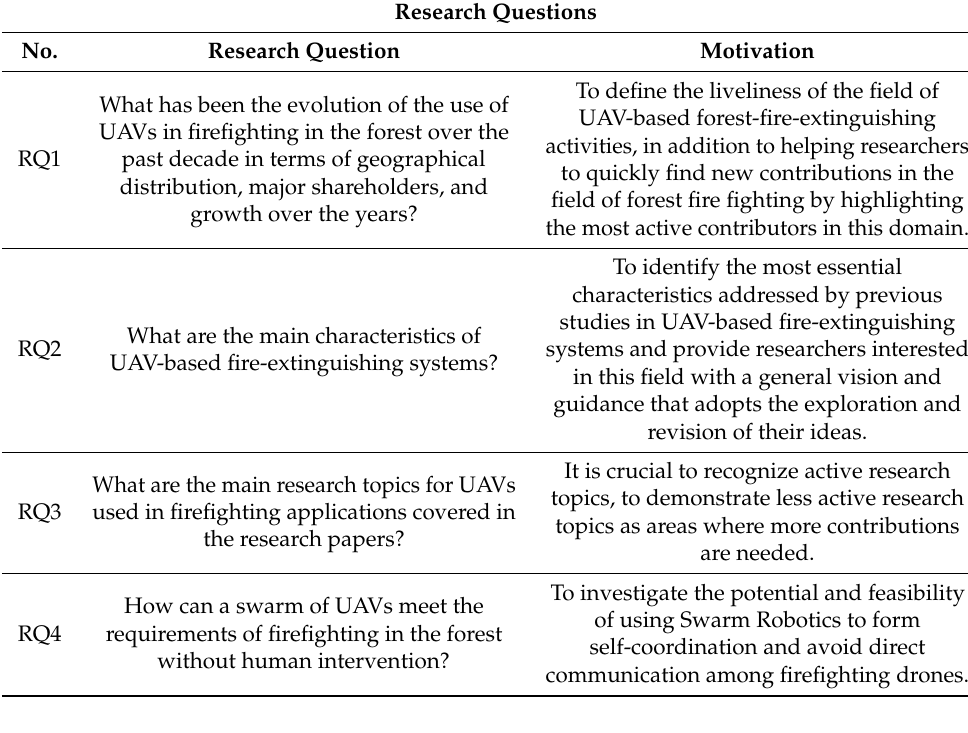
Table 2. SLR search